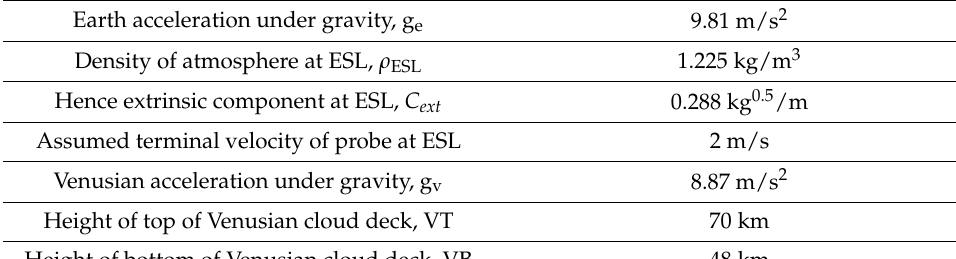
Table 3. Key parameters for extrapolation of probe behaviour in Venusian atmosphere.